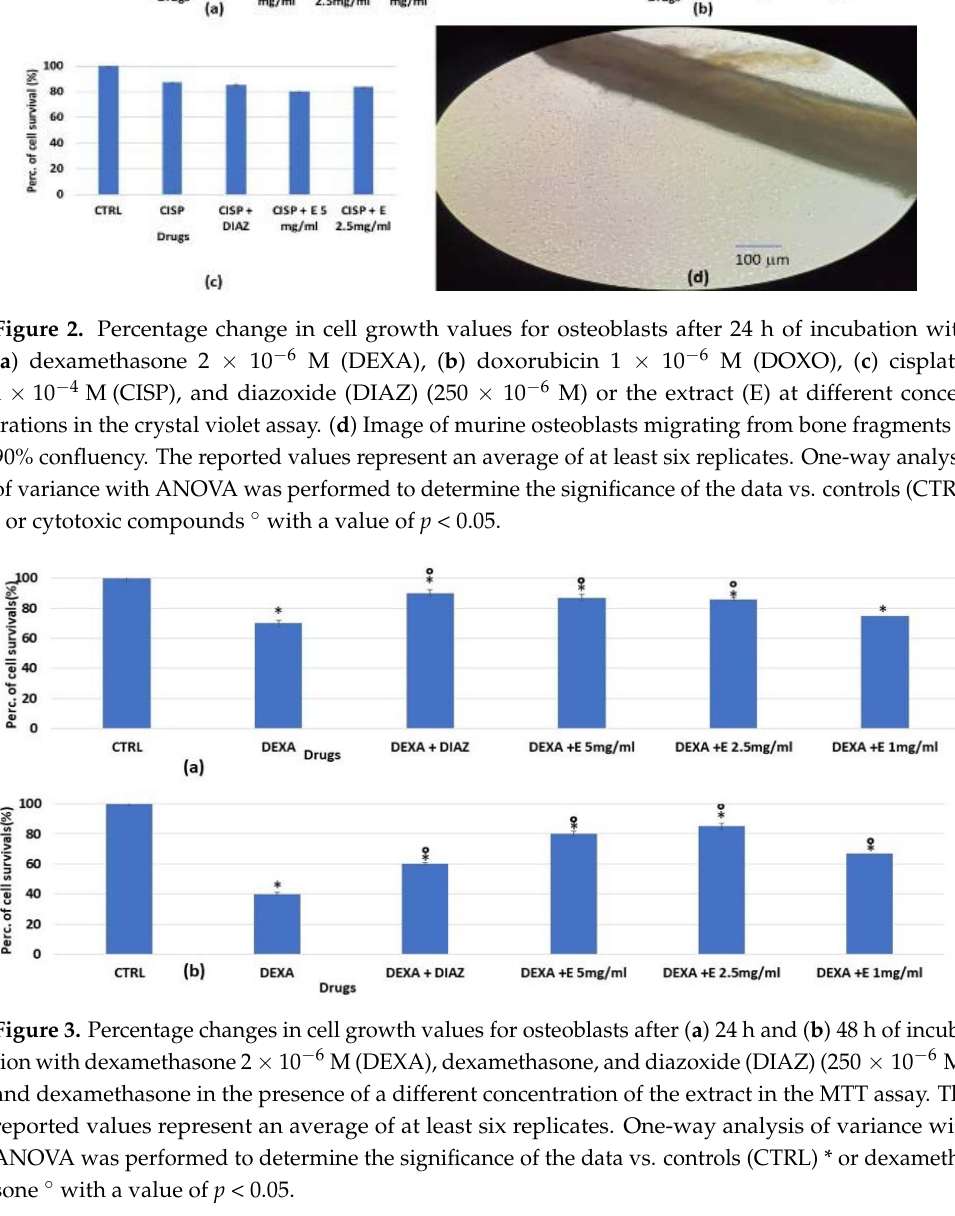
8 of 18 Figure 2. Percentage change in cell growth values for osteoblasts after 24 h of incubation with: ( a ) dexamethasone 2 × 10 − 6 M (DEXA), ( b ) doxorubicin 1 × 10 − 6 M (DOXO), ( c ) cisplatin 1 × 10 − 4 M (CISP), and diazoxide (DIAZ) (250 × 10 − 6 M) or the extract (E) at different concentrations in the crystal violet